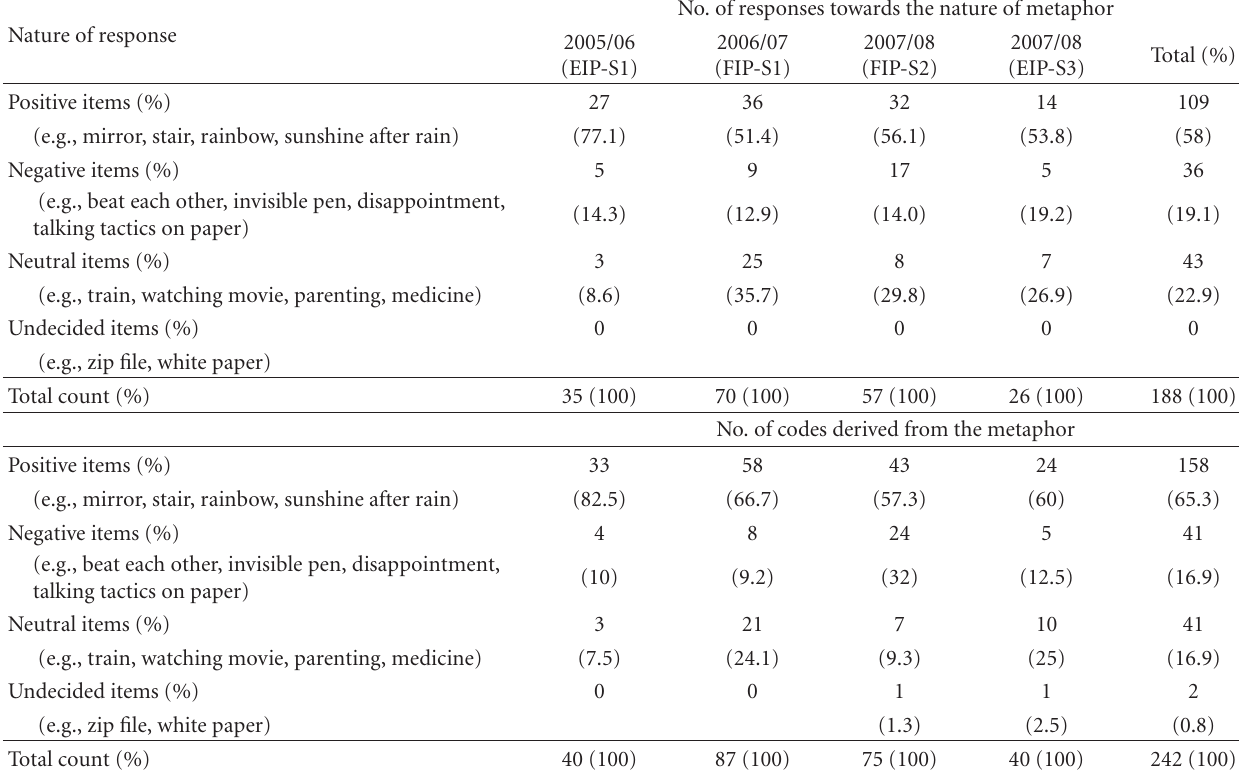
Table 4: Metaphors used by participants to describe the